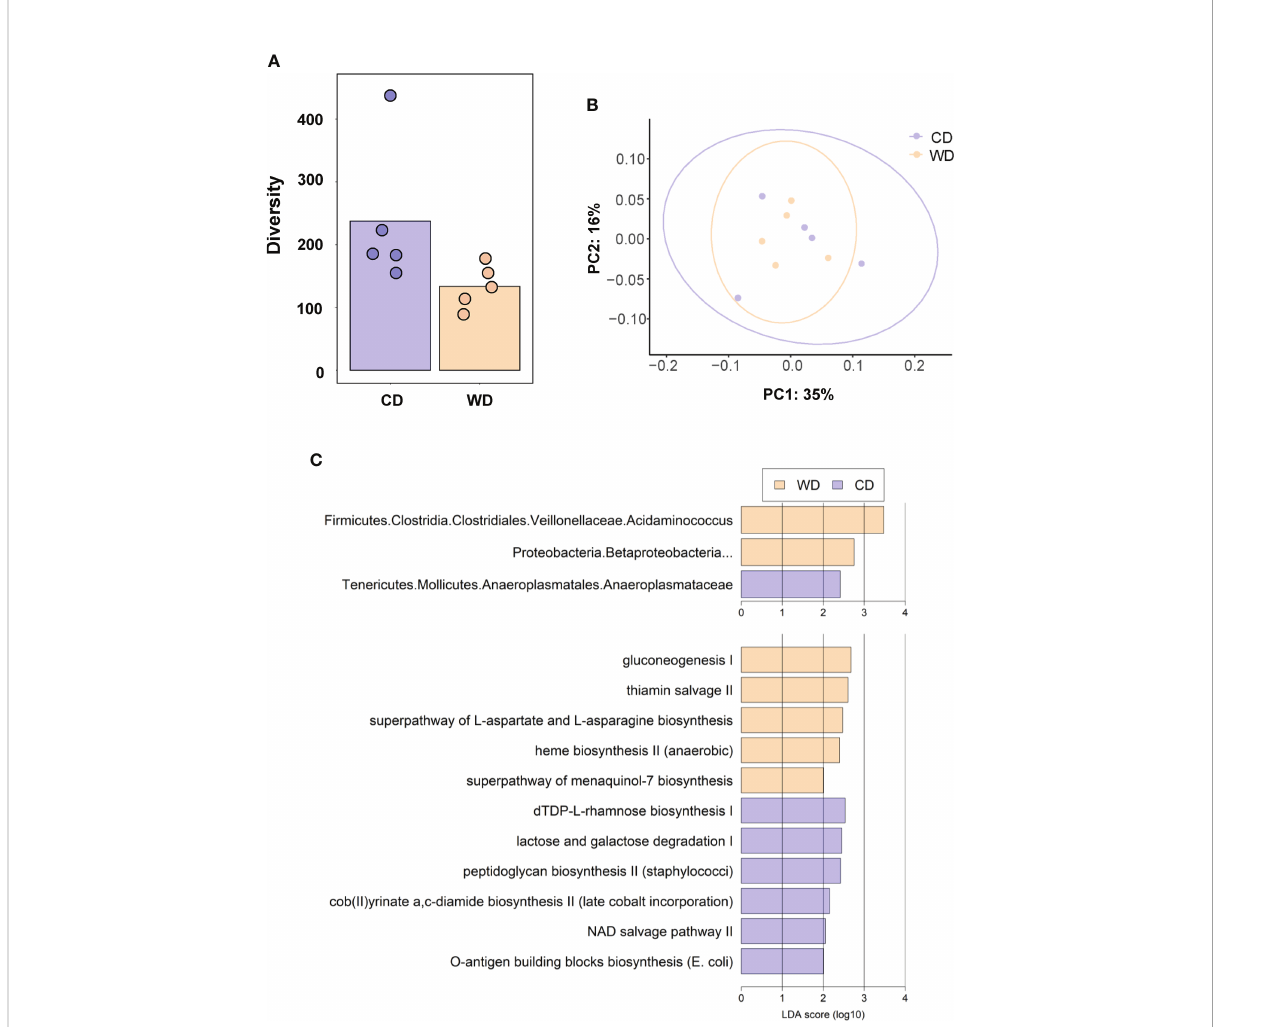
FIGURE 4 (A) Alpha diversity measured using Faith ’ s phylogenetic diversity. Signi fi cance of species richness was tested using the Kruskal-Wallis test ( P = 0.02). (B) PCoA ordination displaying weighted Unifrac beta diversity. Percent variation explained is shown on each axis (PC1: 35% & PC2: 16%). PERMANOVA signi fi cance for the weighted Unifrac distances ( P = 0.26). (C) Lefse histograms plotted for signi fi cant enrichment in taxa abundances (upper plot) and biochemical pathways (lower plot). n =